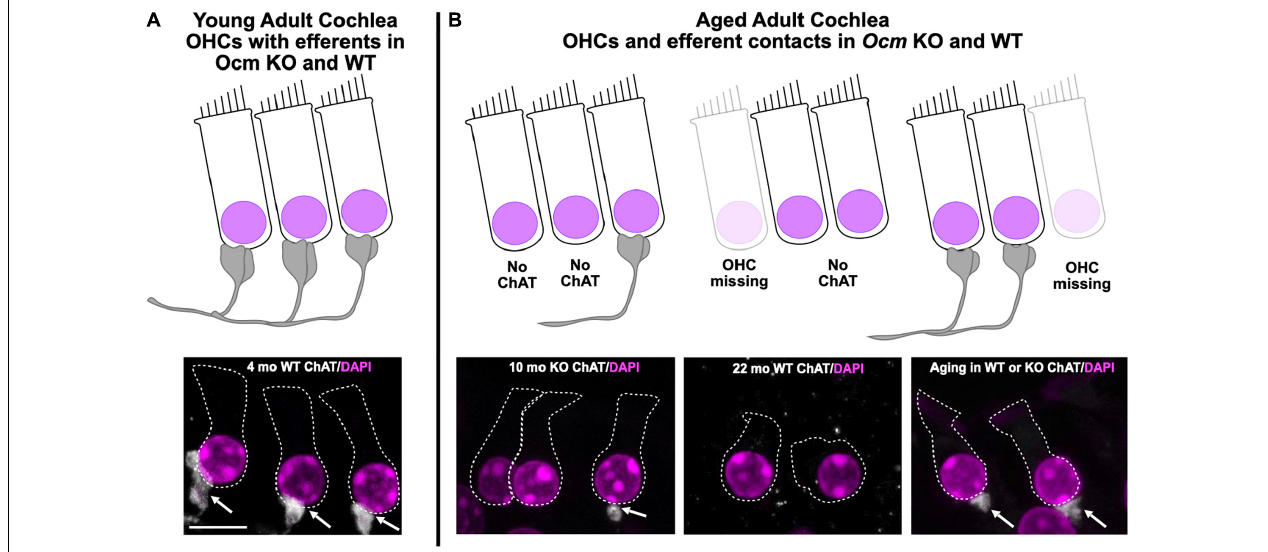
FIGURE 7 | Model of common Ocm KO and aging characteristics. (A) Young adult CBA WT and KO animals have organized OHC rows with efferent clusters present on all cells. (B) During aging, OHCs are lost and not all of the remaining cells will possess efferent synaptic connections. In the WT animals, this occurs after 1 year, but the KOs show efferent and OHC loss much earlier. This demonstrates that dysregulated Ca 2 + signaling can enhance the effects of aging. Scale bar = 10 µ